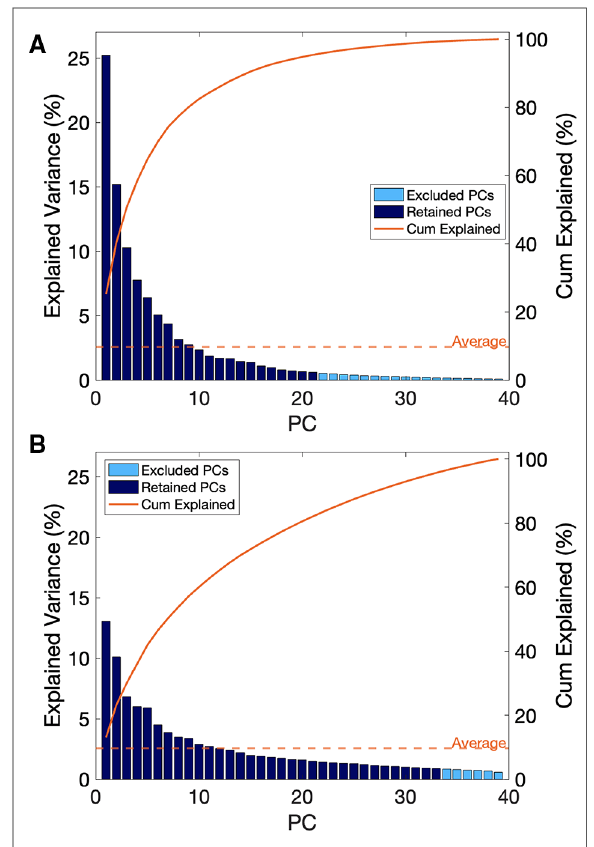
FIGURE 5 ( A ) scree plot for principal components derived from kinematic data, ( B ) scree plot for principal components derived from sEMG data.